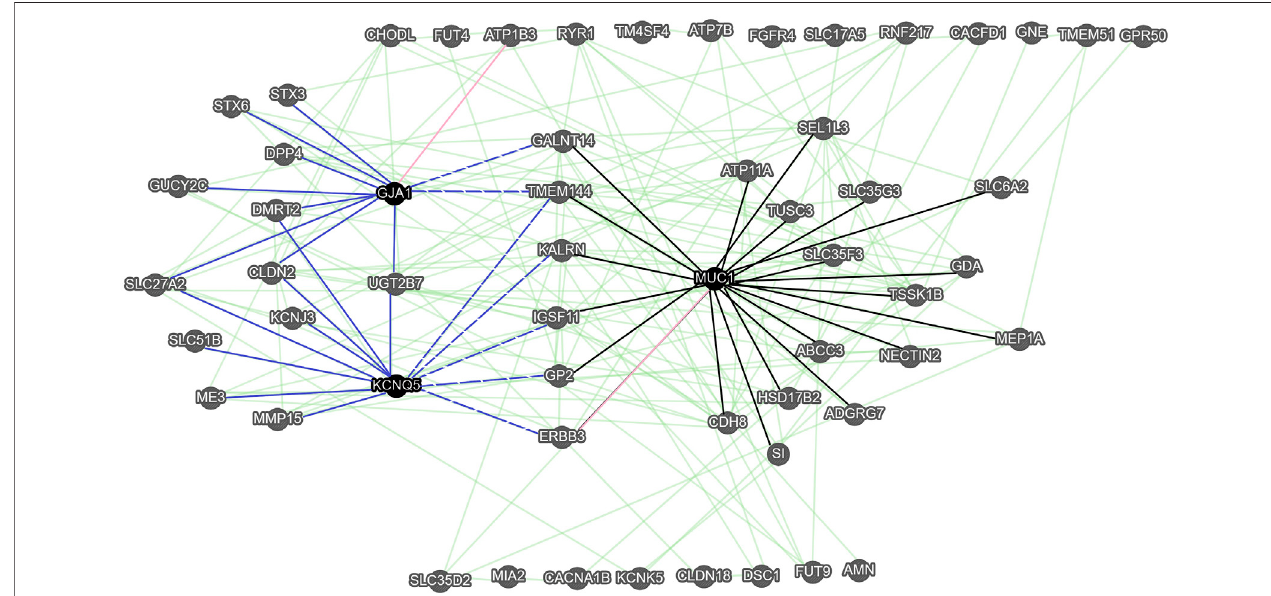
FIGURE 4 | The gene-gene interaction network of membrane protein-encoding genes obtained with GeneMANIA. Green edges correspond to the functional associationsbetweengenes(nodes),whilepinkedgesrepresentthepredictedgene-geneinteraction.Theblackedgescorrespondtogenesfunctionallyassociatedwith theMUC1hubgene(sub-network1).ThesolidblueedgescorrespondtogenesfunctionallyassociatedwiththeKCNQ5andGJA1hubgenes(sub-network2),whilethe blue dashed edges correspond to genes functionally associated with the KCNQ5, GJA1, and